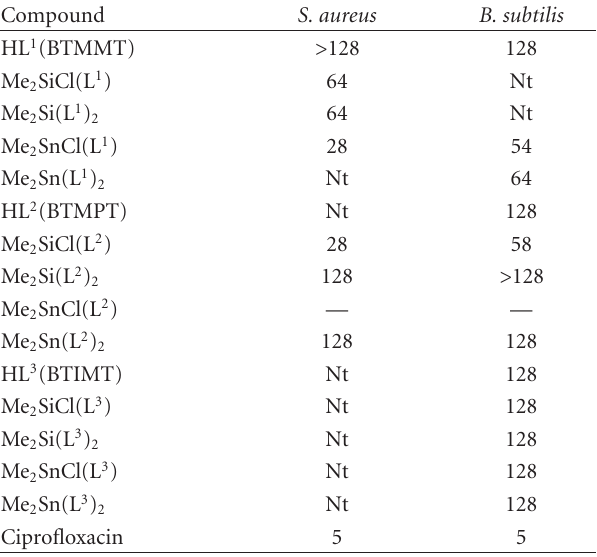
replicates. Table 6: Minimum inhibitory concentration (MIC) in μ g/mL of the ligands and their metal complexes. Compound